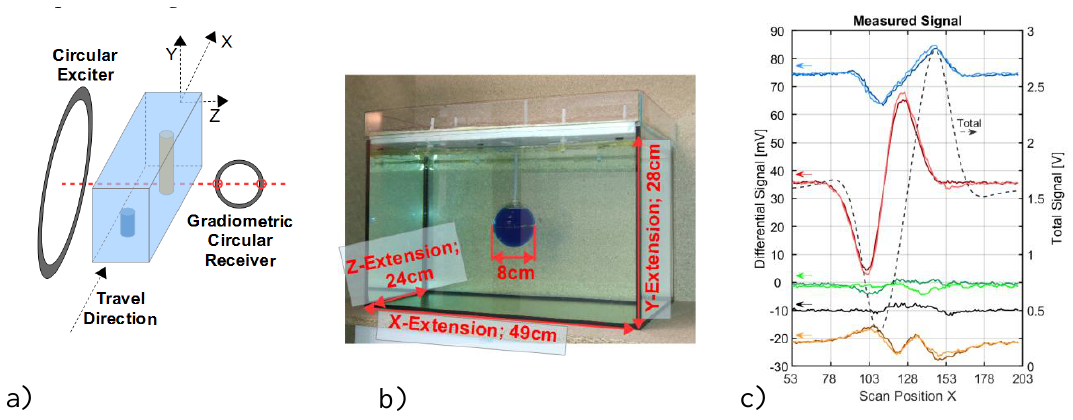
Figure 2. Experiment with a planar MIT setup. ( a ) Schematic illustration; the whole saline body travels linearly in the x-direction through a gradiometric arrangement of excitation and receiving loop. ( b ) The 33-liter saline body with a non-conducting 0.27-liter sphere in the horizontal middle plane. The sphere is steady with respect to the travelling saline body. ( c ) Measurements: The dotted black line represents the total signal of the cuboid; the red lines are the differential signals of the sphere when face-centered at the side wall; the blue and yellow lines represent the signature of the sphere towards the exciter and receiver coils (face-centered). The green lines from the center of the volume are weak, and they approach the noise floor (black line).